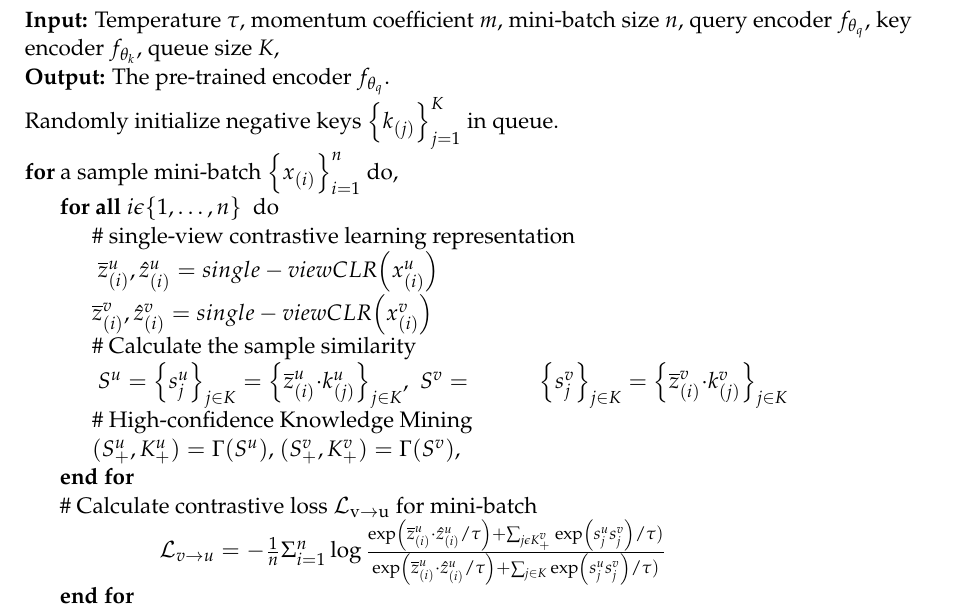
Algorithm 2. Main algorithm of Composite